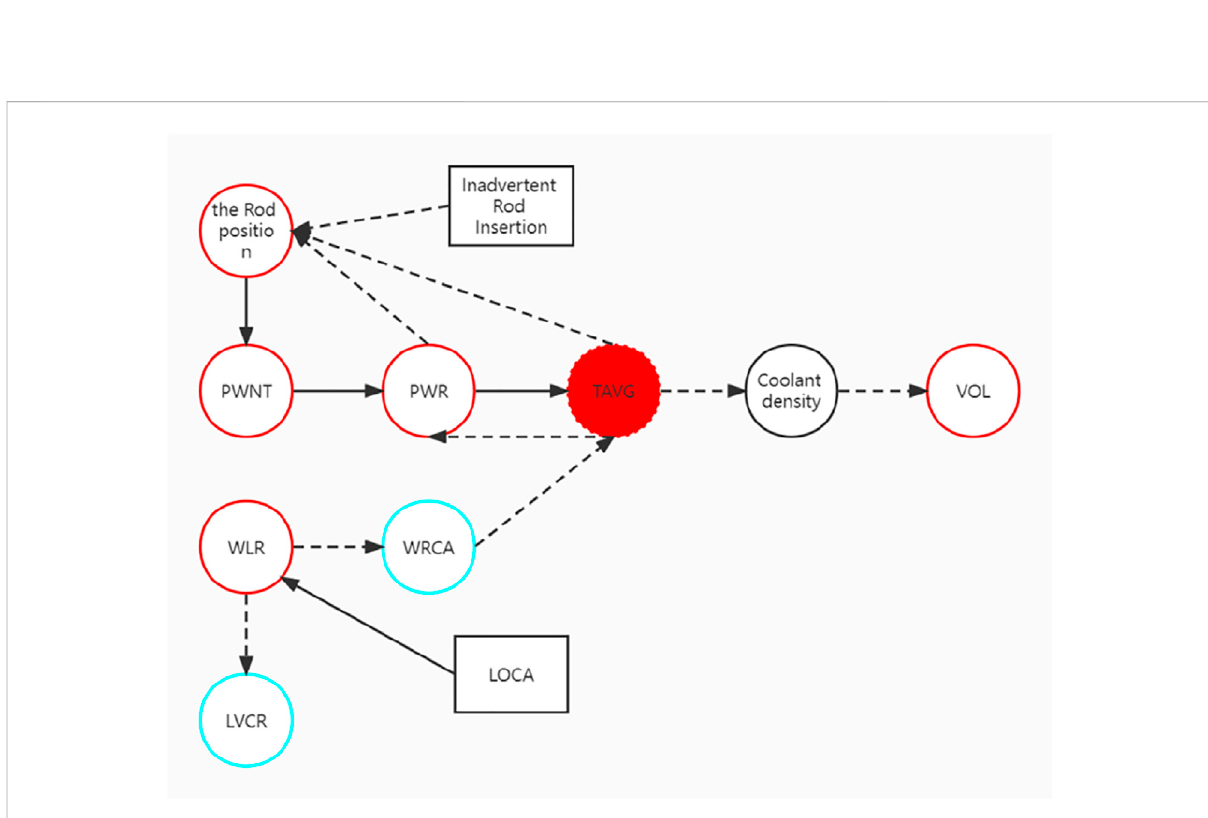
FIGURE 14 Reactor SDG intermediate transient